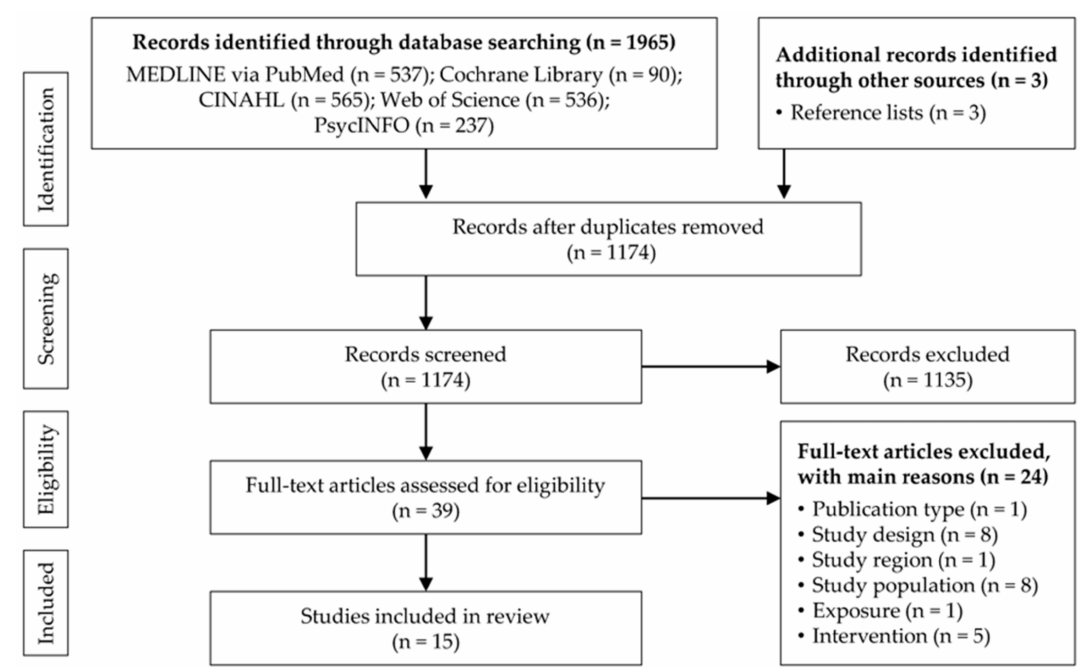
Figure 1. Flow chart of the study selection